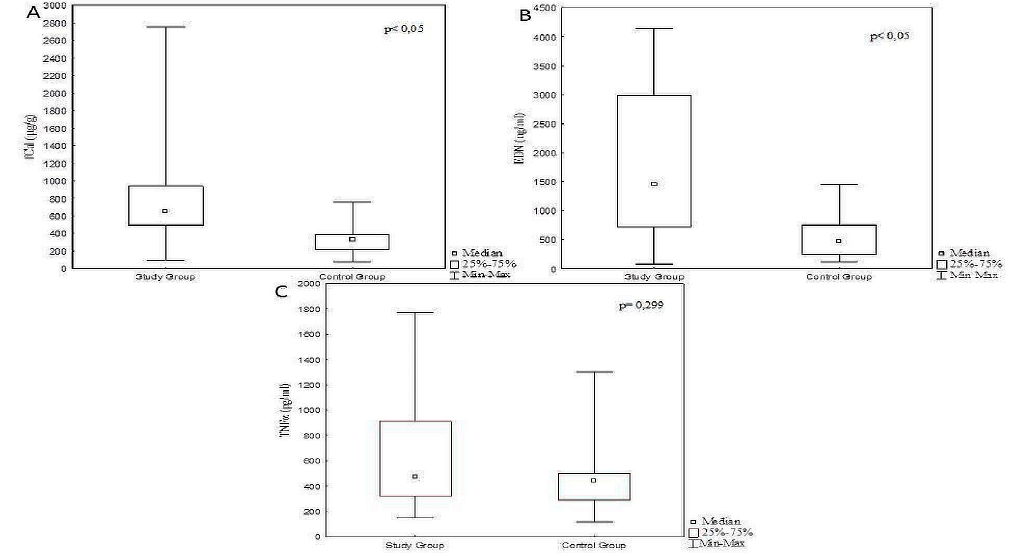
Figure 2. Differences in the concentration of fecal calprotectin ( A ), eosinophil derived neurotoxin ( B ) and tumor necrosis factor α ( C ) in infants with food protein induced allergic proctocolitis (study) and control groups.